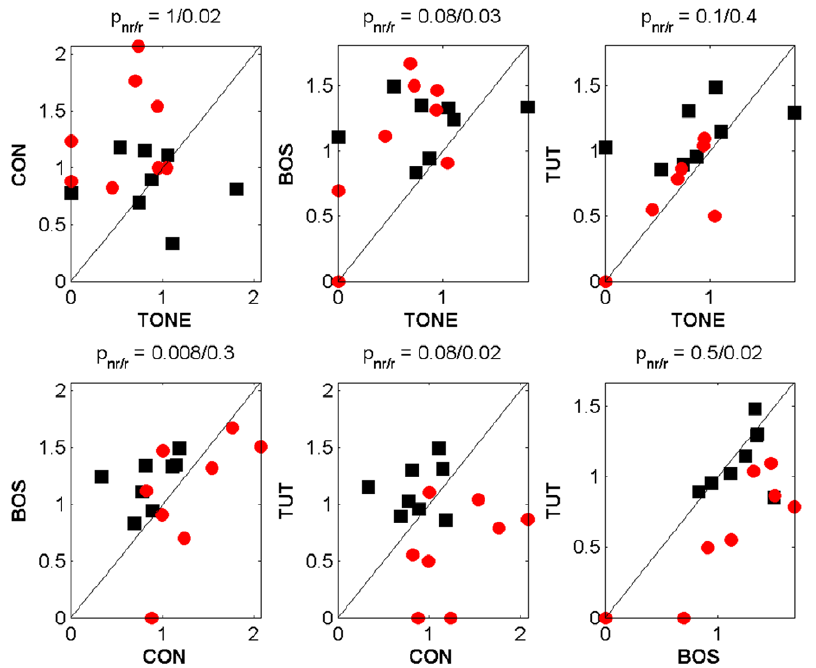
Figure 3. Pairwise comparisons of BOLD responses. Scatterplots of magnitude of BOLD response in the medial posterior forebrain, comparing the four different stimuli, namely TONE, conspecific song (CON), bird’s own song (BOS) and tutor’s song (TUT), pairwise in medial parasagittal slices, in 8 repeaters (red dots) and non-repeaters (black dots) each. Note that most of the red dots fall below the diagonal when TUT is compared with CON and BOS. p-values at the top of each panel indicate significance for the hypothesis that the two stimuli of that panel elicited the same response (Wilcoxon signed rank test), for non-repeaters and repeaters each.